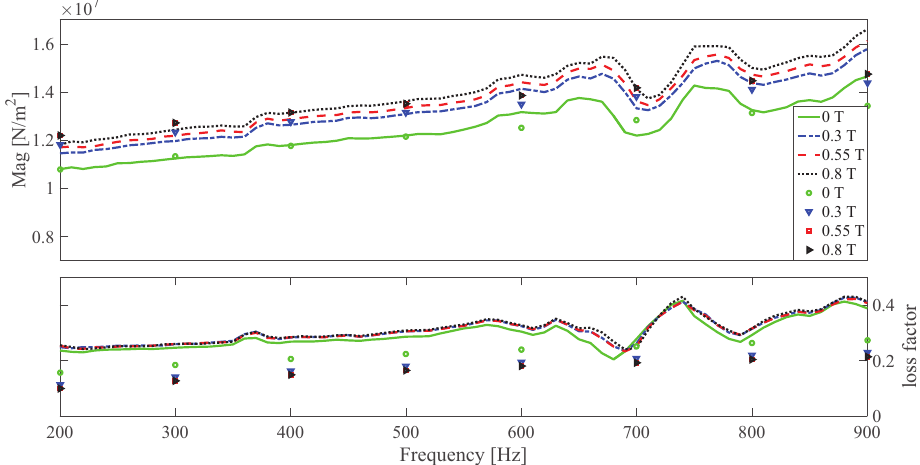
Figure 6. The magnitude and loss factor of the dynamic shear modulus versus frequency at 0.0005 strain amplitude and 273K. Lines and symbols are the measurement and simulation results, respectively.